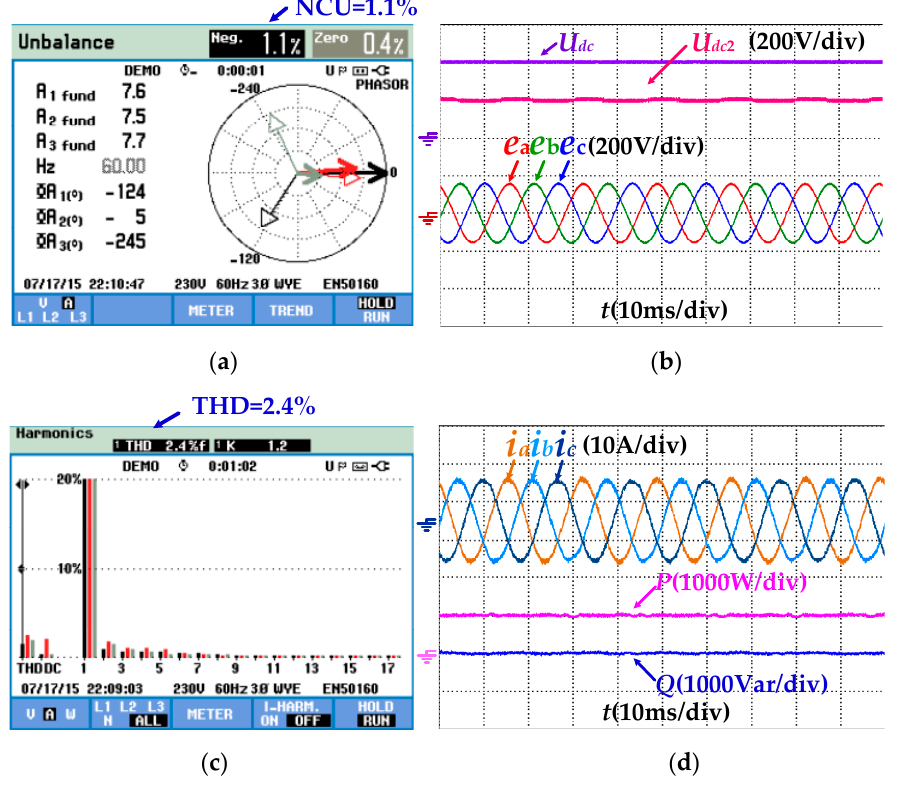
Figure 13. Experimental results of proposed MPDPC for fault-tolerant BVSC in inverter mode with leg faults of phase a ( a ) negative current unbalance; ( b ) voltage waveform; ( c ) harmonics spectrum; ( d ) current and power waveform.